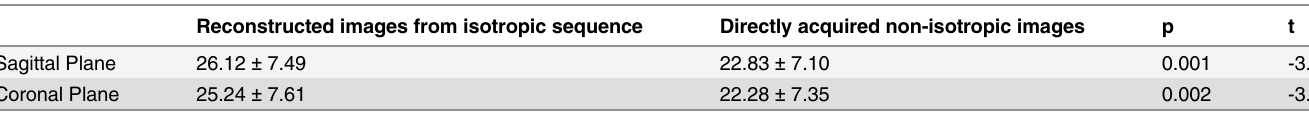
Table 3. Estimated SNR.